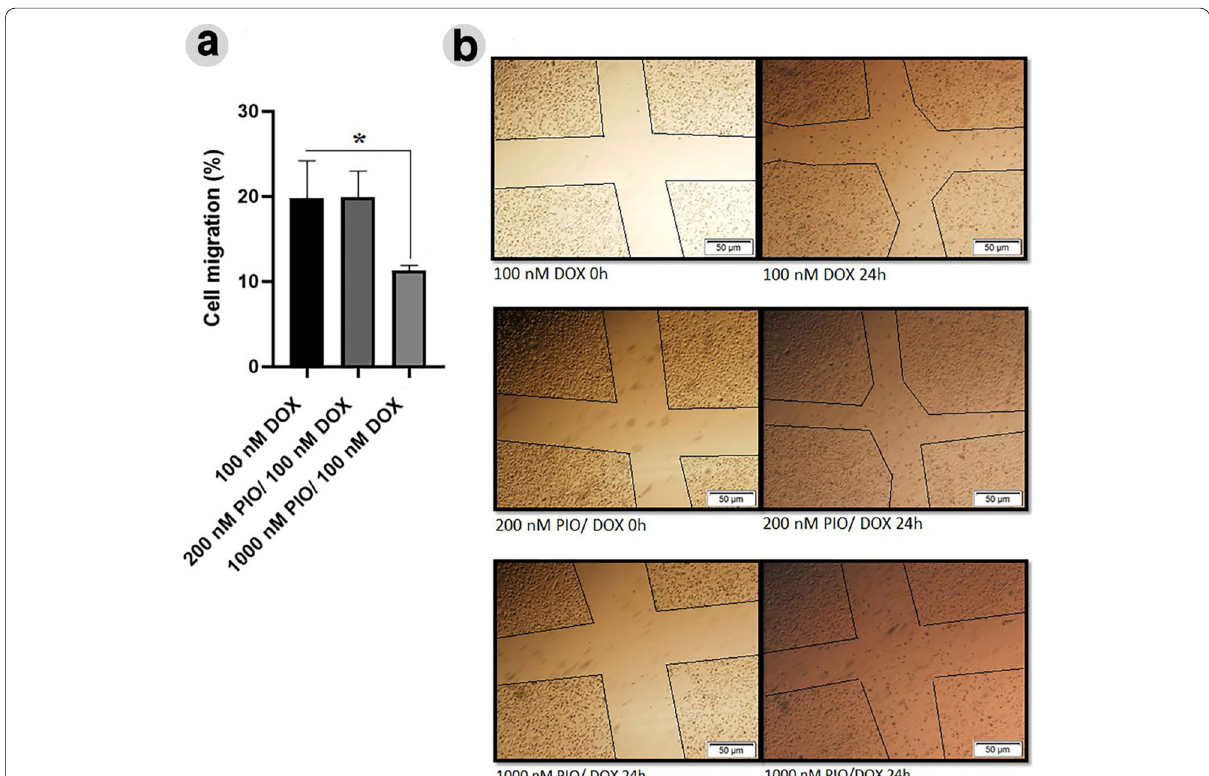
Fig. 4 a The percentage of the wound area filled by migrated cells after 24 h analyzed by ImageJ in groups treated with DOXO and each dose of PIO simultaneously ( P 0.049). b The pictures of the wound areas after 24 h in main groups of =